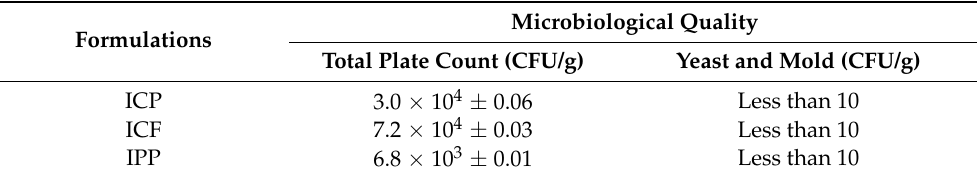
Table 7. Microbiological quality assessment of instant porridge